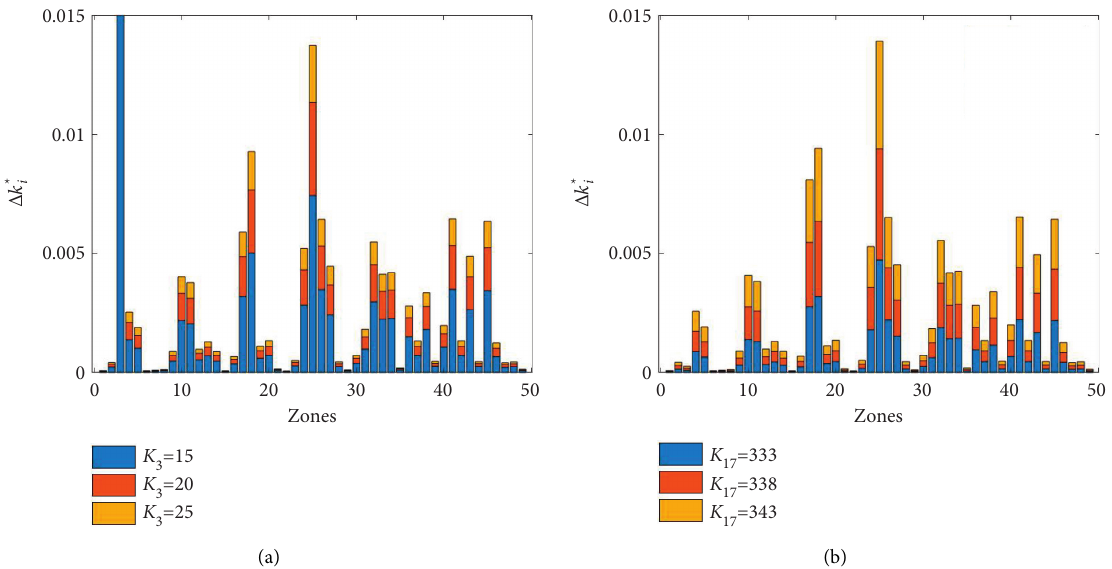
Figure 7: The change of k ∗ K 17